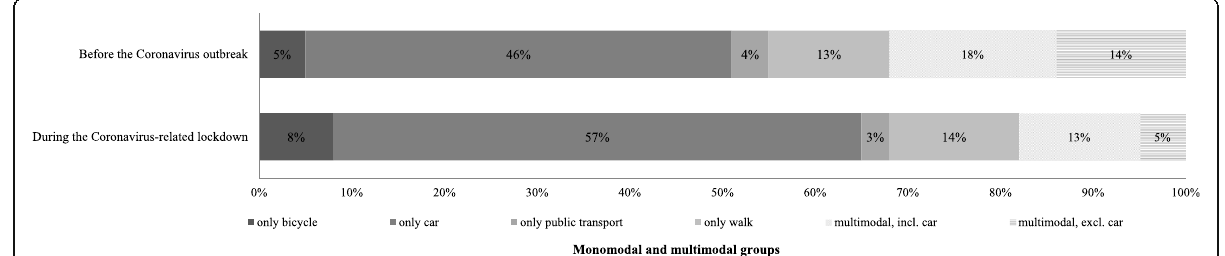
Fig. 2 Usage patterns of different modes of transportation before the Coronavirus pandemic and during the Coronavirus-related lockdown for shopping trips (people who buy at least monthly in stores before the Coronavirus pandemic, n =